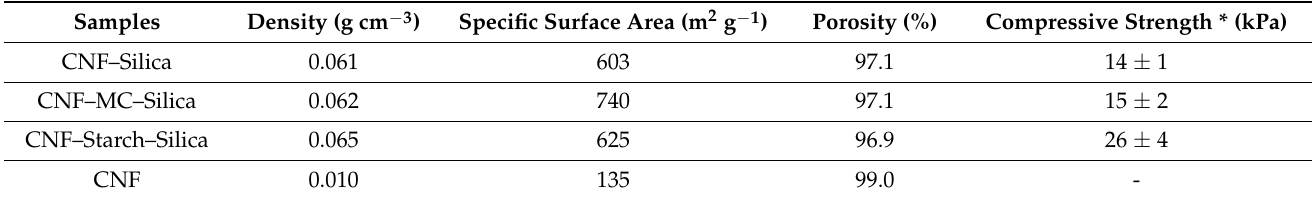
Table 1. Properties of CNF–silica gels and the influence of the addition of starch or methylcellulose (MC). The standard deviation of the average compressive strengths is reported ( n =